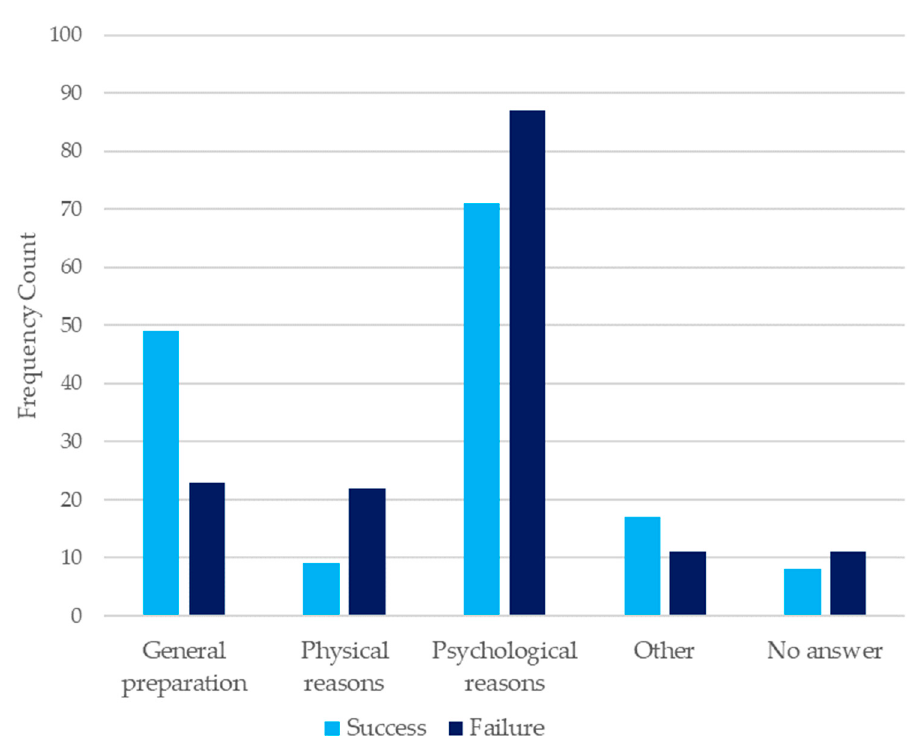
Figure 2. Frequency counts for success and failure attributions.